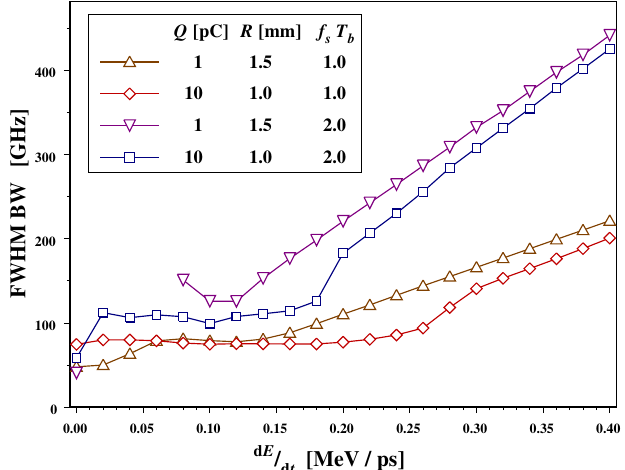
FIG. 8. (Color) FWHM bandwidth of the radiation as a function of the energy chirp rate dE